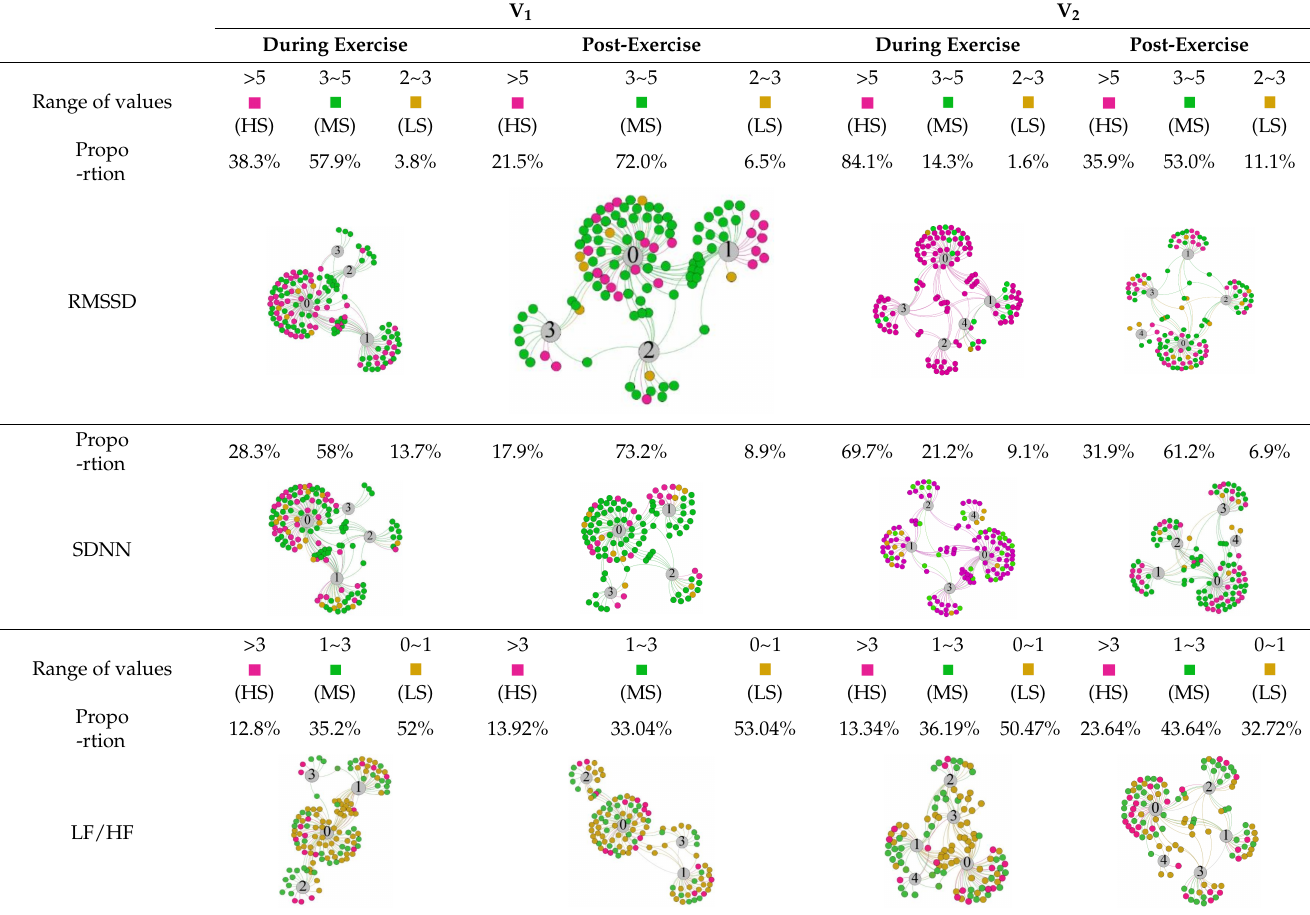
Table 8. The force-directed graphs between heart rate variability (HRV) and TSV. V 1 V 2 Post-Exercise During Exercise